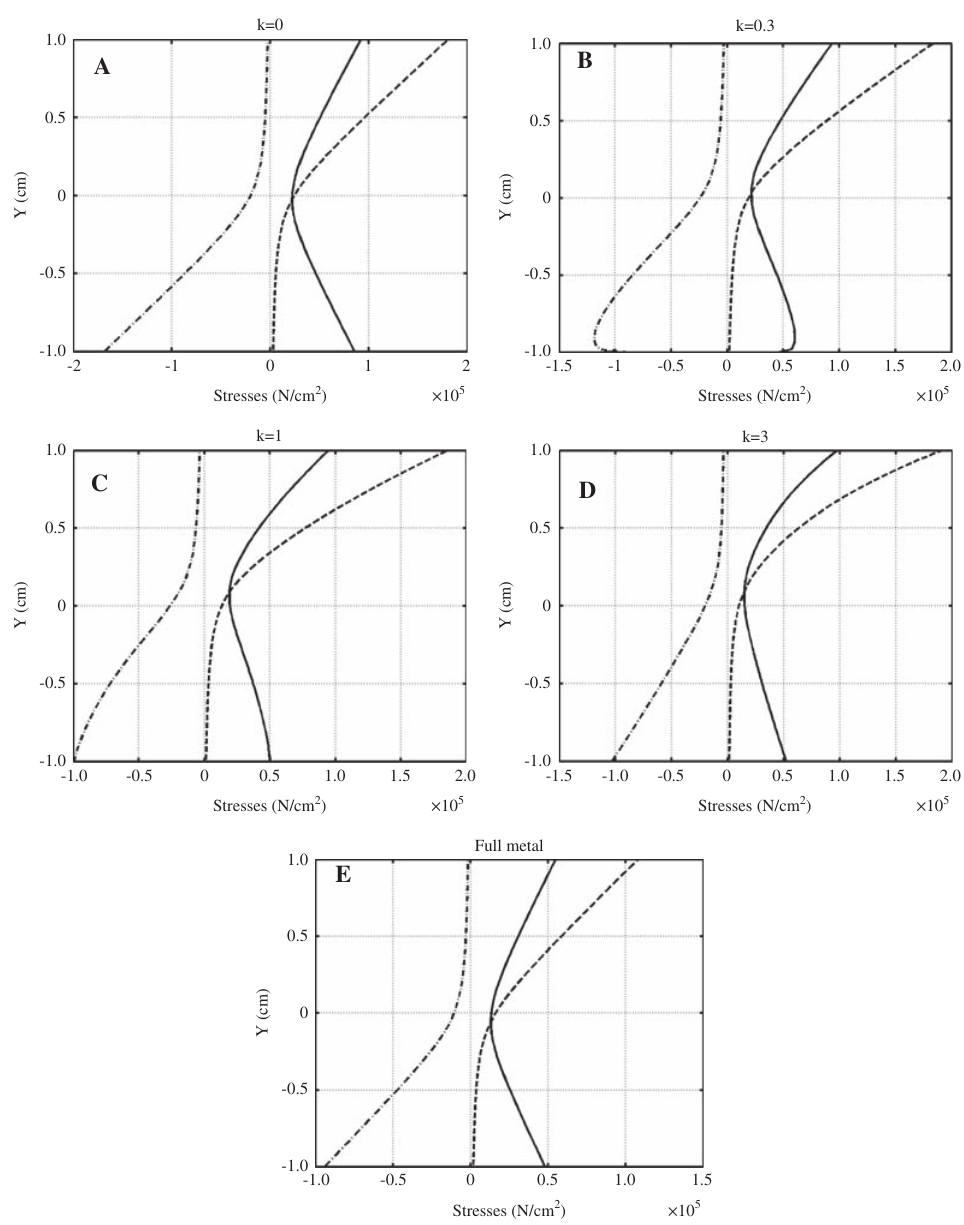
Figure 15 The principal stresses 2 σ q = 500 N/cm 2 in the geometrically non-linear case, 2 σ